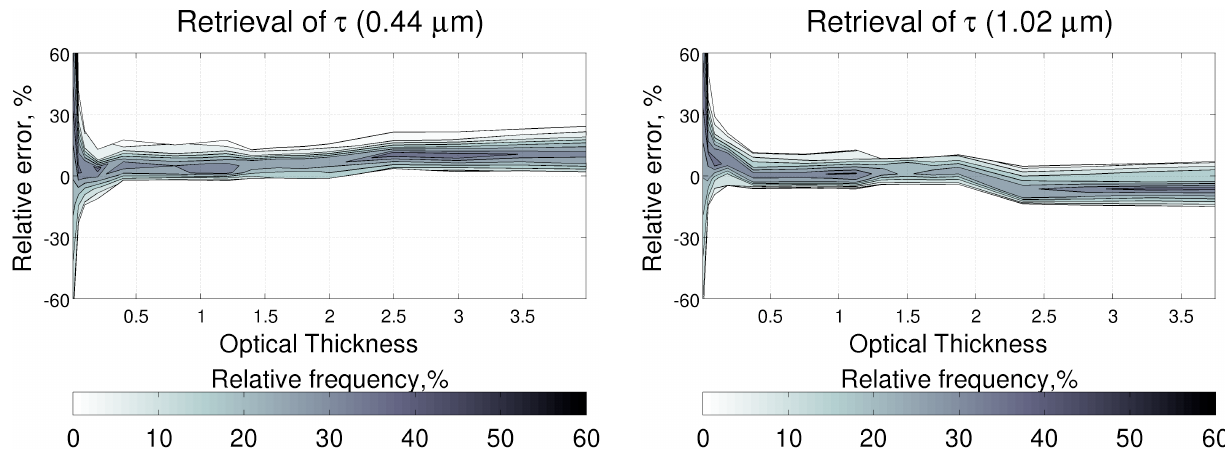
2 Fig. 18. Statistics of the retrieval errors of desert dust optical thickness over Banizoumbou in the series of the numerical tests for 100 different realizations of random noise added (multi-pixel retrieval): (left panel) 0.44µm; (right panel)